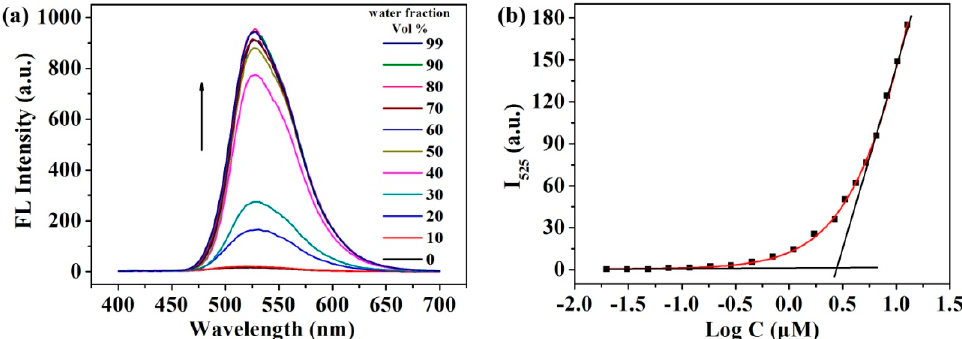
Figure 1. ( a ) Fluorescence spectra of AIE-1 in dimethyl sulfoxide (DMSO)/water mixtures; ( b ) Determination of the critical micelle concentration (CMC) of AIE-1.